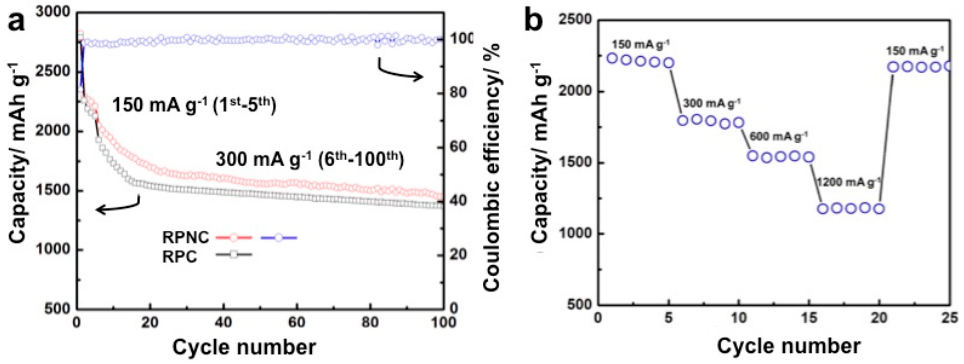
Figure 6. ( a ) The comparison of cycling performances and coulombic efficiency of RPNC and RPC; ( b ) the rate capability of RPNC composite at various current densities. ( b ) the rate capability of RPNC composite at various current